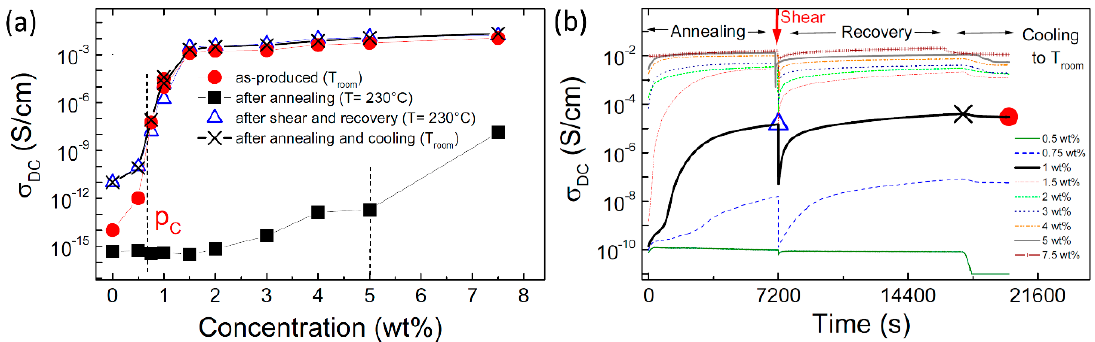
Figure 12. Percolation for injection molded polycarbonate plates with MWCNTs before and after annealing: ( a ) at room temperature (solid state) and ( b ) time evolution of the conductivity during annealing in the melt at 230 °C for samples with different MWCNT contents [65].